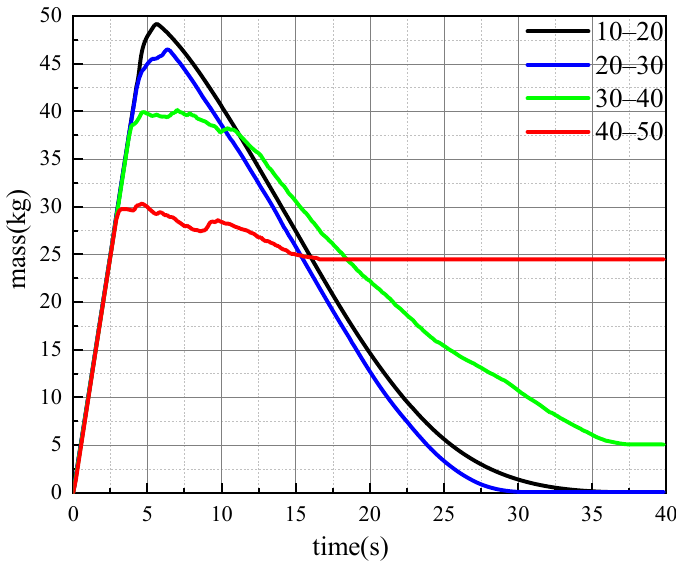
Figure 15. Particle mass in the pump.